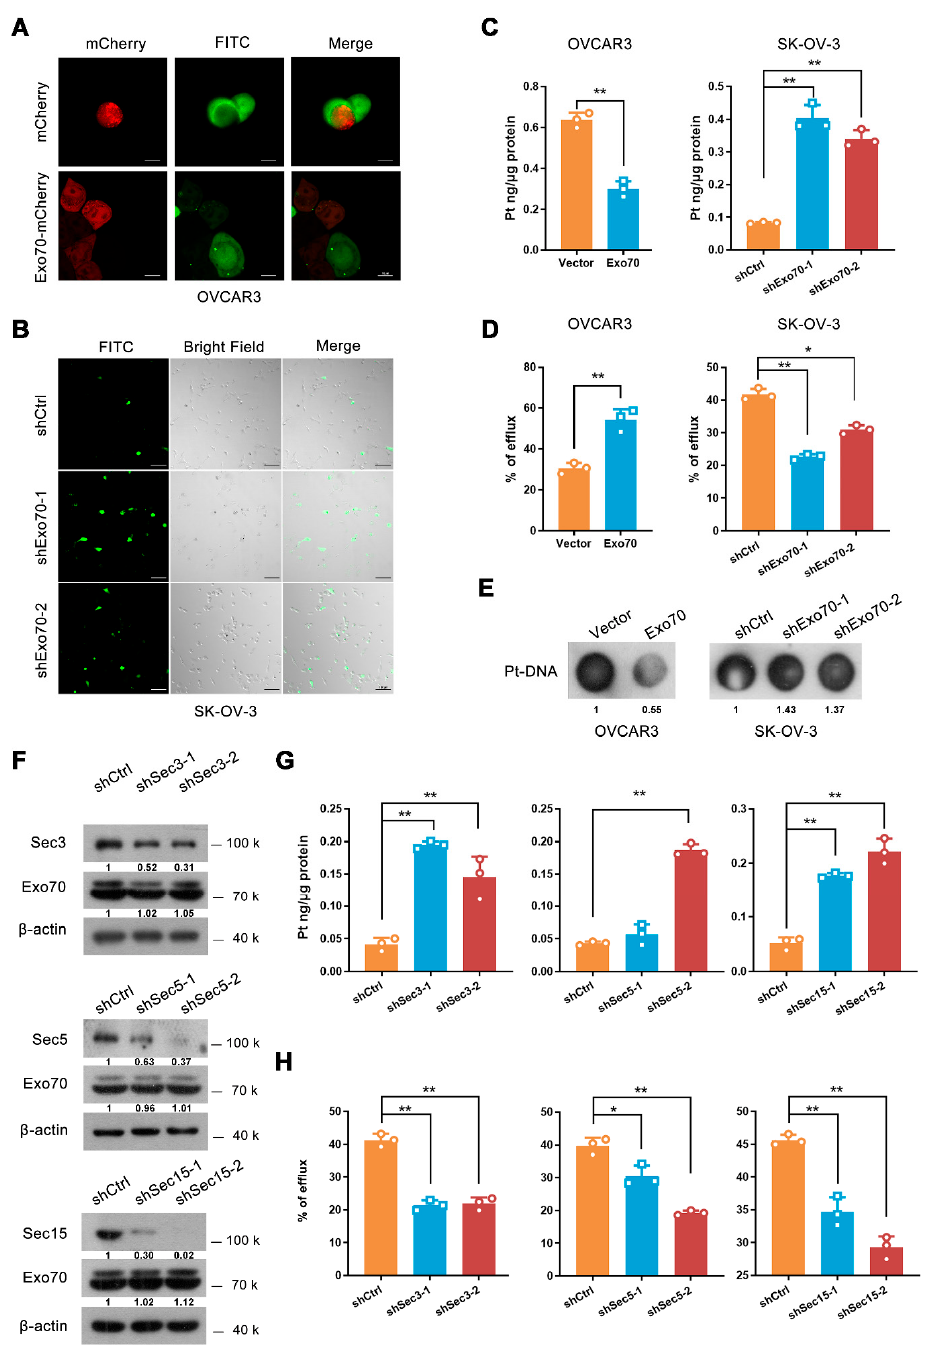
Figure 3. Exo70 reduces the intracellular accumulation of cisplatin through exocytosis. ( A ) Representative images of OVCAR3 cells treated with FITC-cisplatin. OVCAR3 cells expressing mCherry or mCherry-Exo70 were mixed with unlabeled OVCAR3 cells, incubated with FITC-cisplatin for 3 h, and then visualized by confocal microscopy. Scale bar, 10 µ m. ( B ) Representative images of SK-OV-3 cells treated with FITC-cisplatin. SK-OV-3 cells were cultured with FITC- Cisplatin for 3 h and then visualized by confocal microscopy. Scale bar, 100 µ m. ( C ) ICP-MS showed the intracellular cisplatin accumulation in OVCAR3 and SK-OV-3 cells. Data were expressed as mean ± SEM, n = 3. ** p < 0.01. ( D ) ICP-MS evaluated the percentage of extracellular cisplatin in OVCAR3 and SK-OV-3 cells. Data were expressed as mean ± SEM, n = 3. * p < 0.05, ** p < 0.01. ( E ) Dot-blot detected cisplatin-DNA adduct in genomic DNA in OVCAR3 and SK-OV-3 cells. ( F ) Western blotting showed shRNA-mediated knockdown of Sec3, Sec5, and Sec15 in SK-OV-3 cells. ( G , H ) ICP-MS was used to detect the intracellular cisplatin accumulation ( G ) and percentage of extracellular cisplatin ( H ) in SK-OV-3 cells. Data were expressed as mean ± SEM, n = 3. * p < 0.05, ** p <